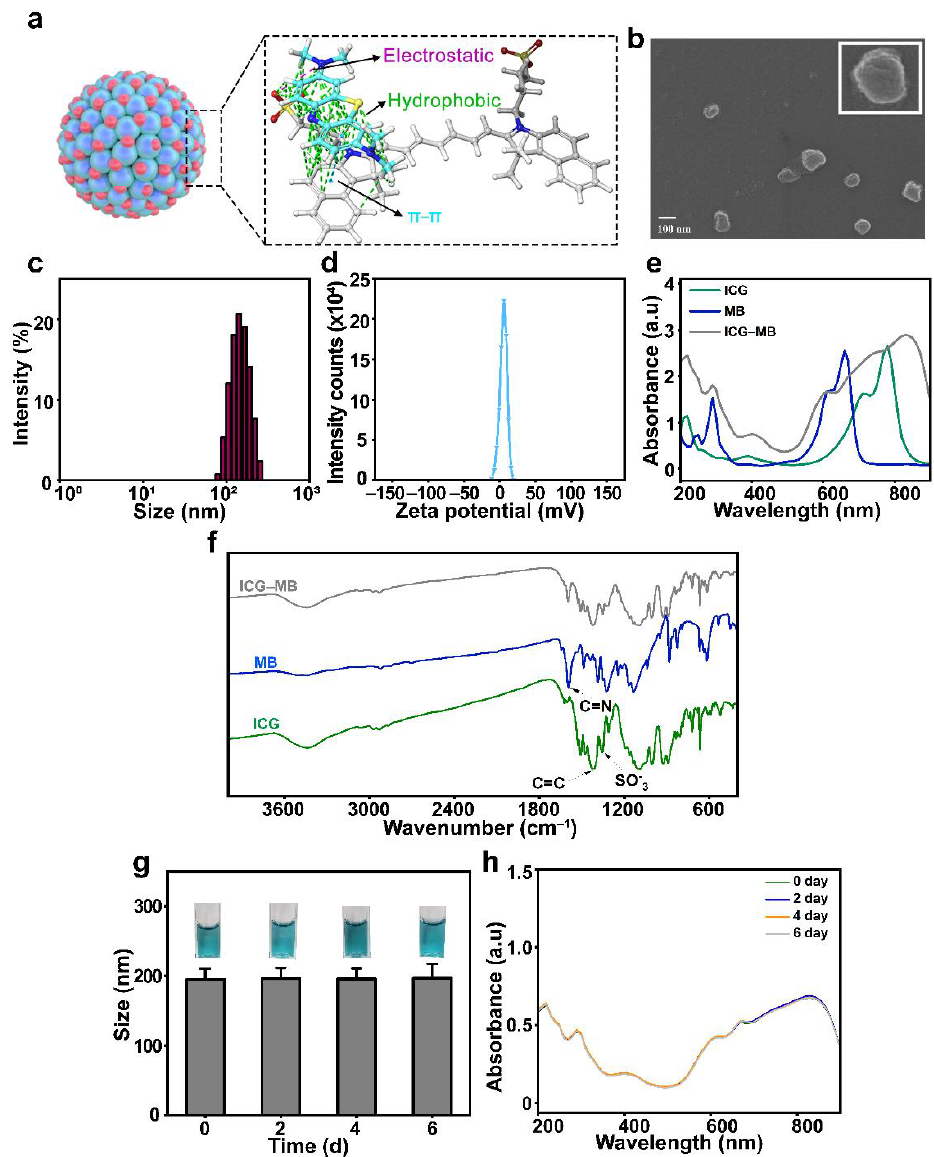
Figure 1. ( a ) Illustration of interaction forces between ICG and MB for self-assembly. ( b ) SEM image of ICG-MB. ( c ) DLS analysis of ICG-MB. ( d ) Zeta potential of ICG-MB. ( e ) UV-vis-NIR absorption spectra of free ICG, free MB and ICG-MB. ( f ) FT-IR spectra of free ICG, free MB and ICG-MB. ( g ) The hydrodynamic size changes of ICG-MB in PBS with 10% of FBS for six days. ( h ) UV-Vis-NIR absorption spectra of ICG-MB for six days after synthesis.